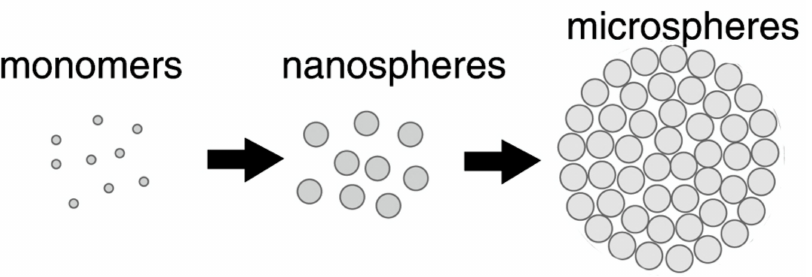
Figure 1. Silicic acid monomers polymerize to from microspherical aggregates. Precipitation of amorphous silica proceeds through three phases, where silicic acid polymers transition from a solution phase to a precipitated solid.